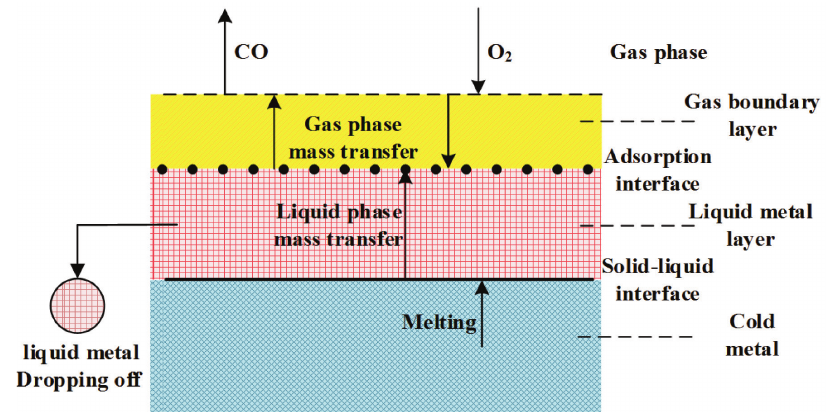
Fig. 2: Macro-kinetic model of melting and decarburization process